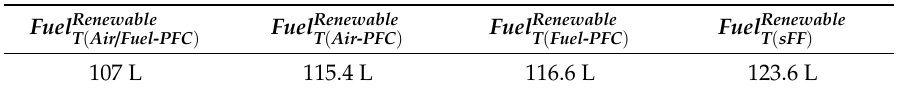
Table 3. Fuel consumption of FC / renewable HPS using the strategies sFF, air-PFC, fuel-PFC, and air /